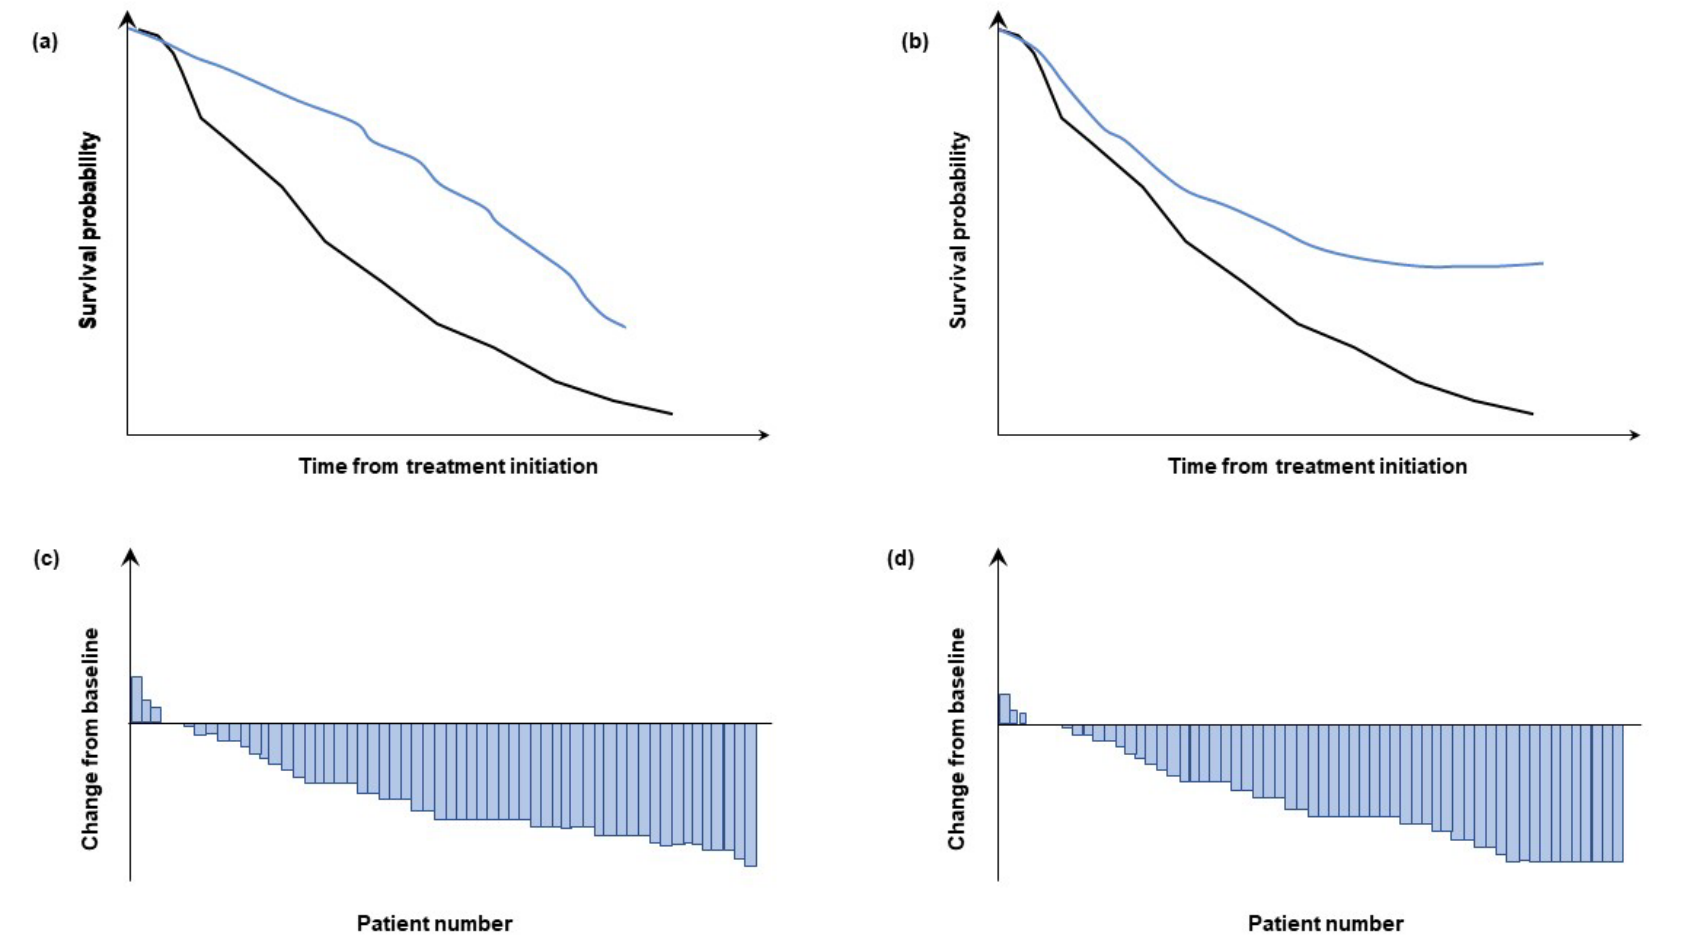
Figure 3. Illustration of the implications of meaningful clinical read out selection for establishing the potential additive versus synergistic effects of anti-VEGF and CPI therapies. Kaplan–Meier curves showing (vs. black reference group) a continued drop off ( a ) versus a plateau ( b ) and waterfall plots ( c , d ) with differing shoulders but the same median. CPI, checkpoint inhibitor; VEGF, vascular endothelial growth factor.